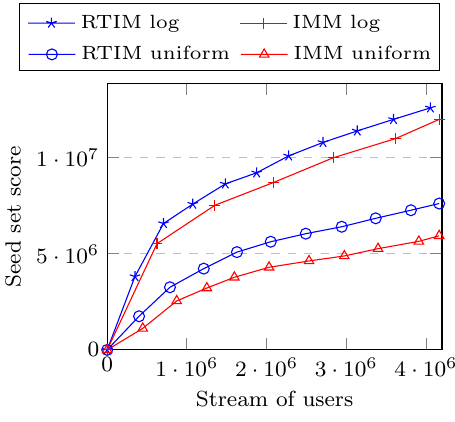
Fig. 9 Seed set score evolution with